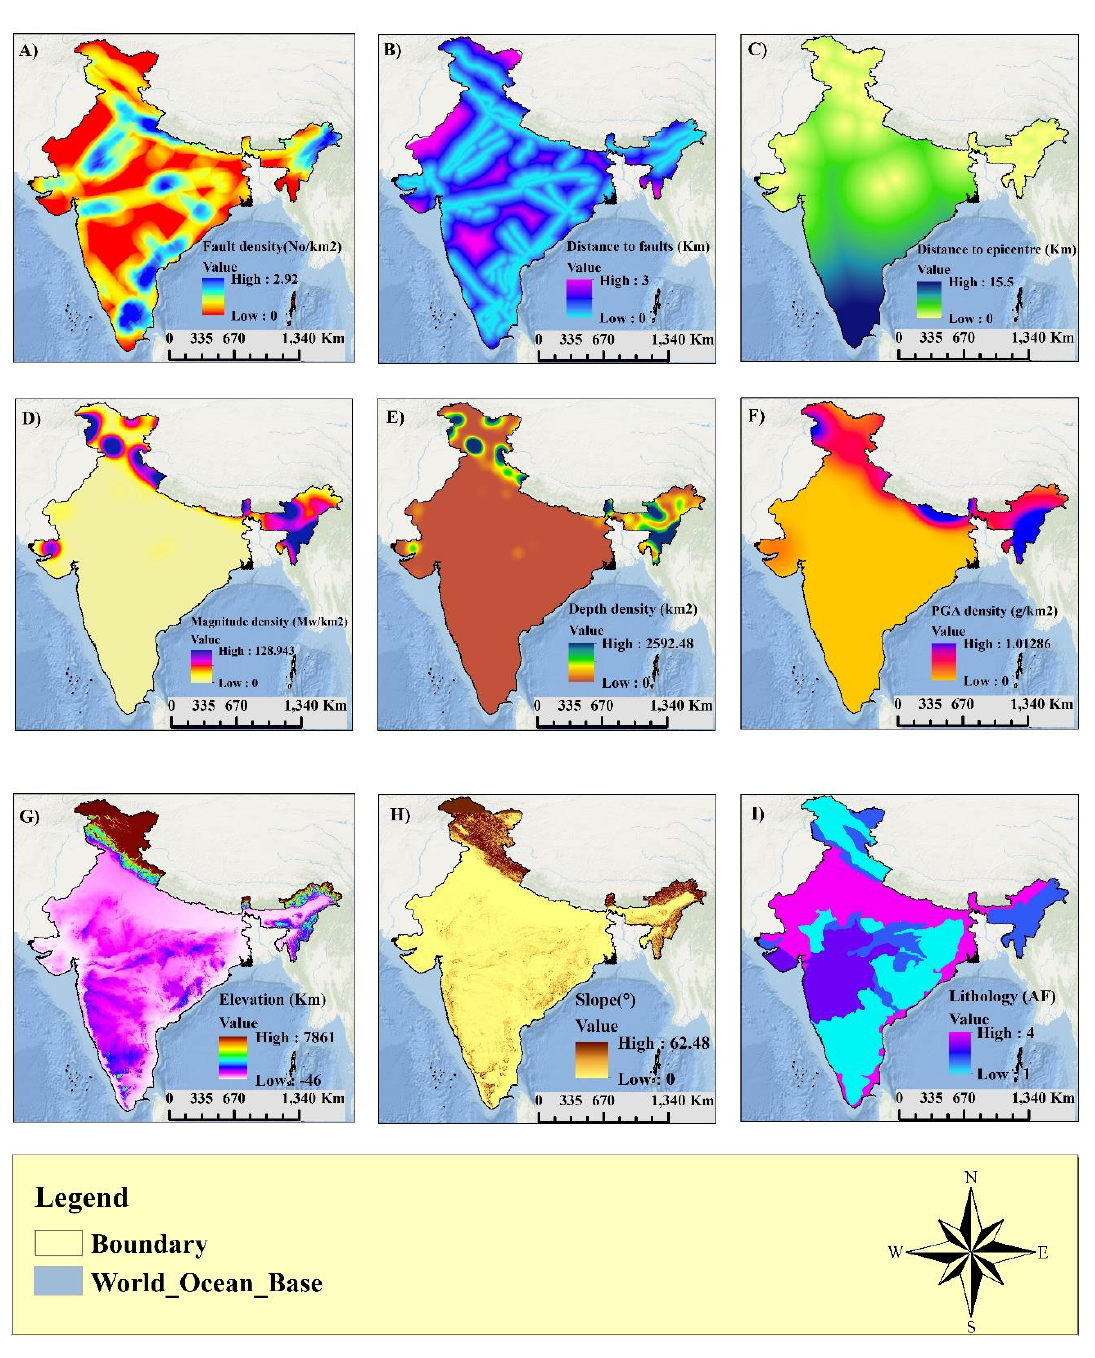
Figure A1. Thematic data indicators for the earthquake probability assessment. (No.: number; km: kilometer; km 2 : square kilometer; °: degree; g: gal) .